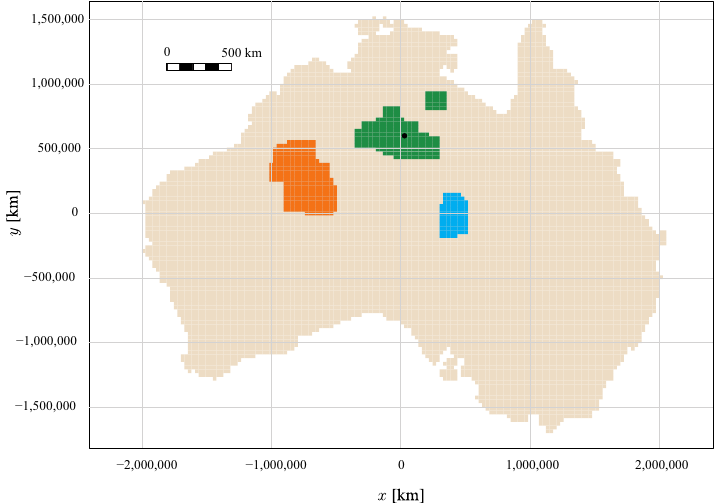
Figure 1. Drought events occurring, on 2 November 2012 in Australia displayed in the Lambert Azimuthal Equal Area coordinate system with a resolution of 27.442 km × 29.079 km. The three different drought events are given different